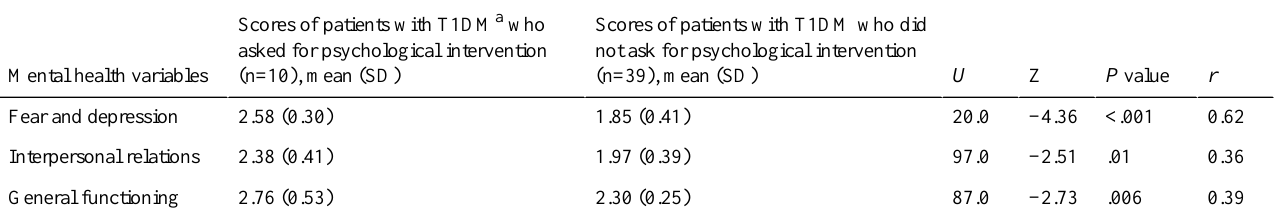
Table 4. General mental health in the examined